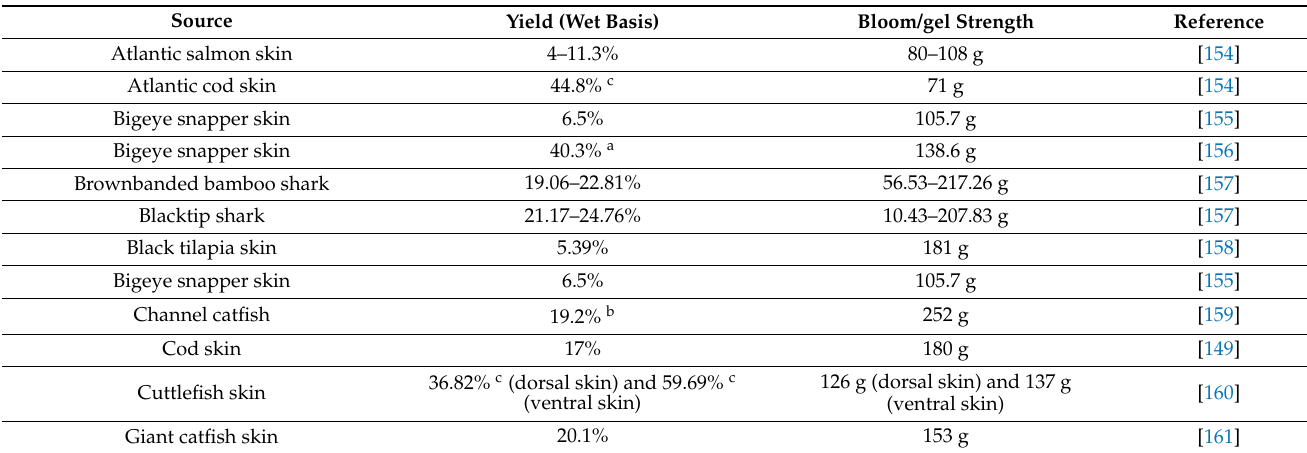
Table 4. Aquatic animals derived gelatin